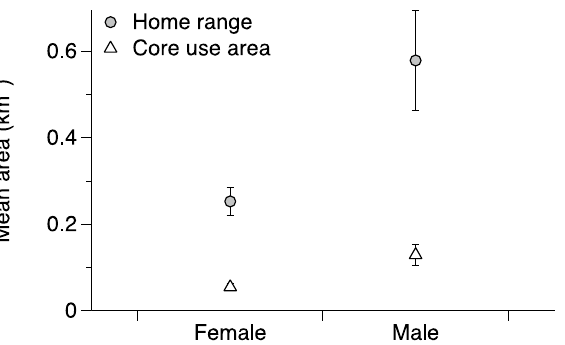
Figure 2. Mean home ranges and core use areas of male and female scrub pythons ( Simalia amethistina ) in Cape York. Home range size was calculated based on 100% minimum convex polygons and core use areas were calculated based on 50% kernel densities. See text for